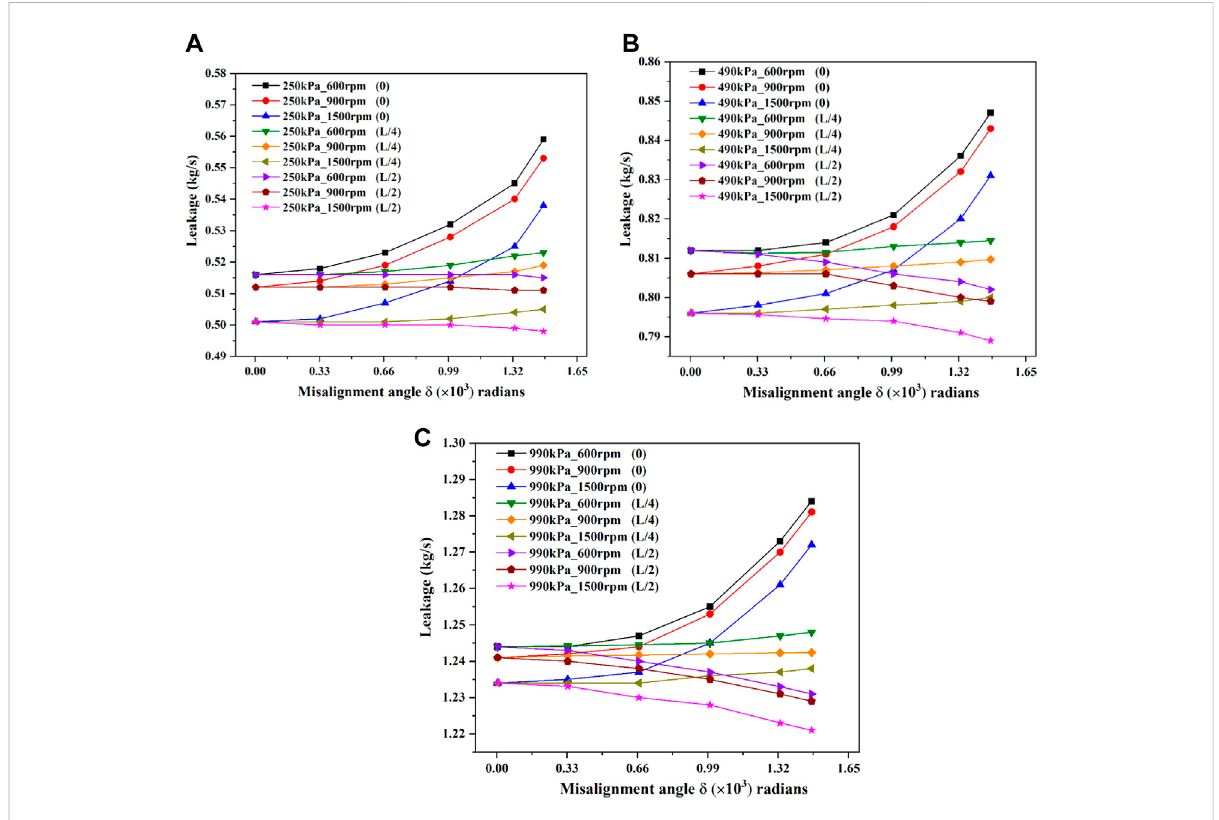
FIGURE 16 The variations of leakage fl owrates with misalignment angle under different pressure differences and rotational speeds. (A) 250 kPa. (B) 490 kPa. (C) 990